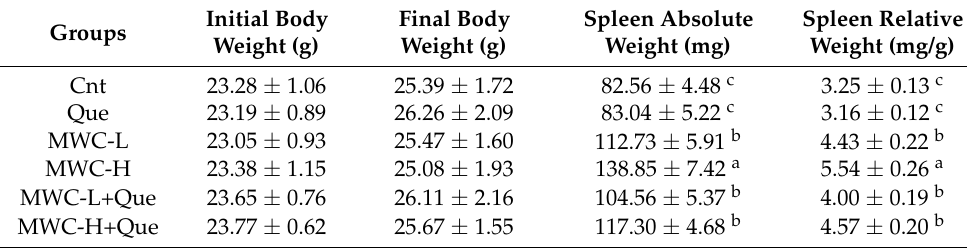
Table 2. Effect of MWCNTs and/or Que on body weight and spleen weight.